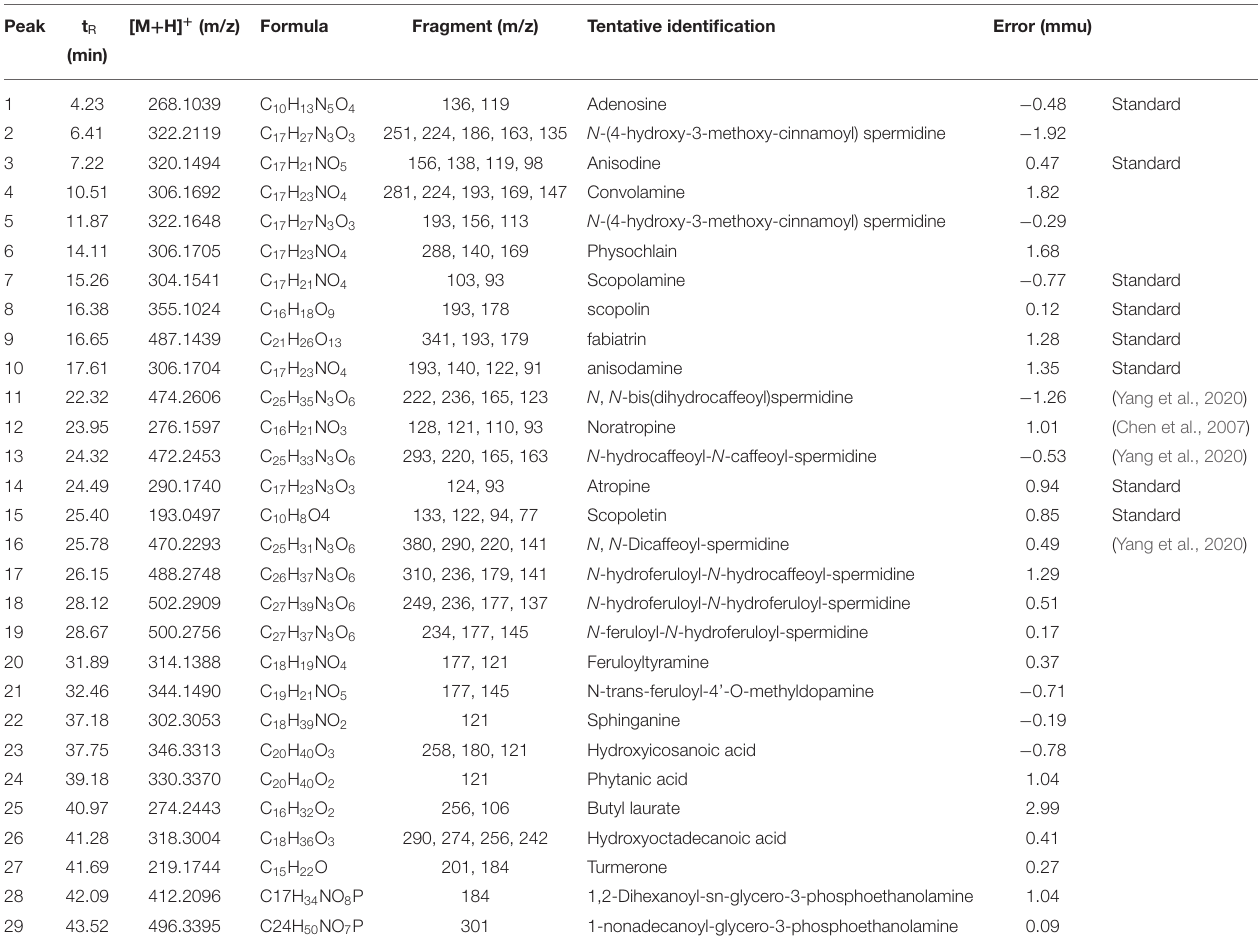
TABLE 1 | Mass spectrometric data of A. tanguticus .